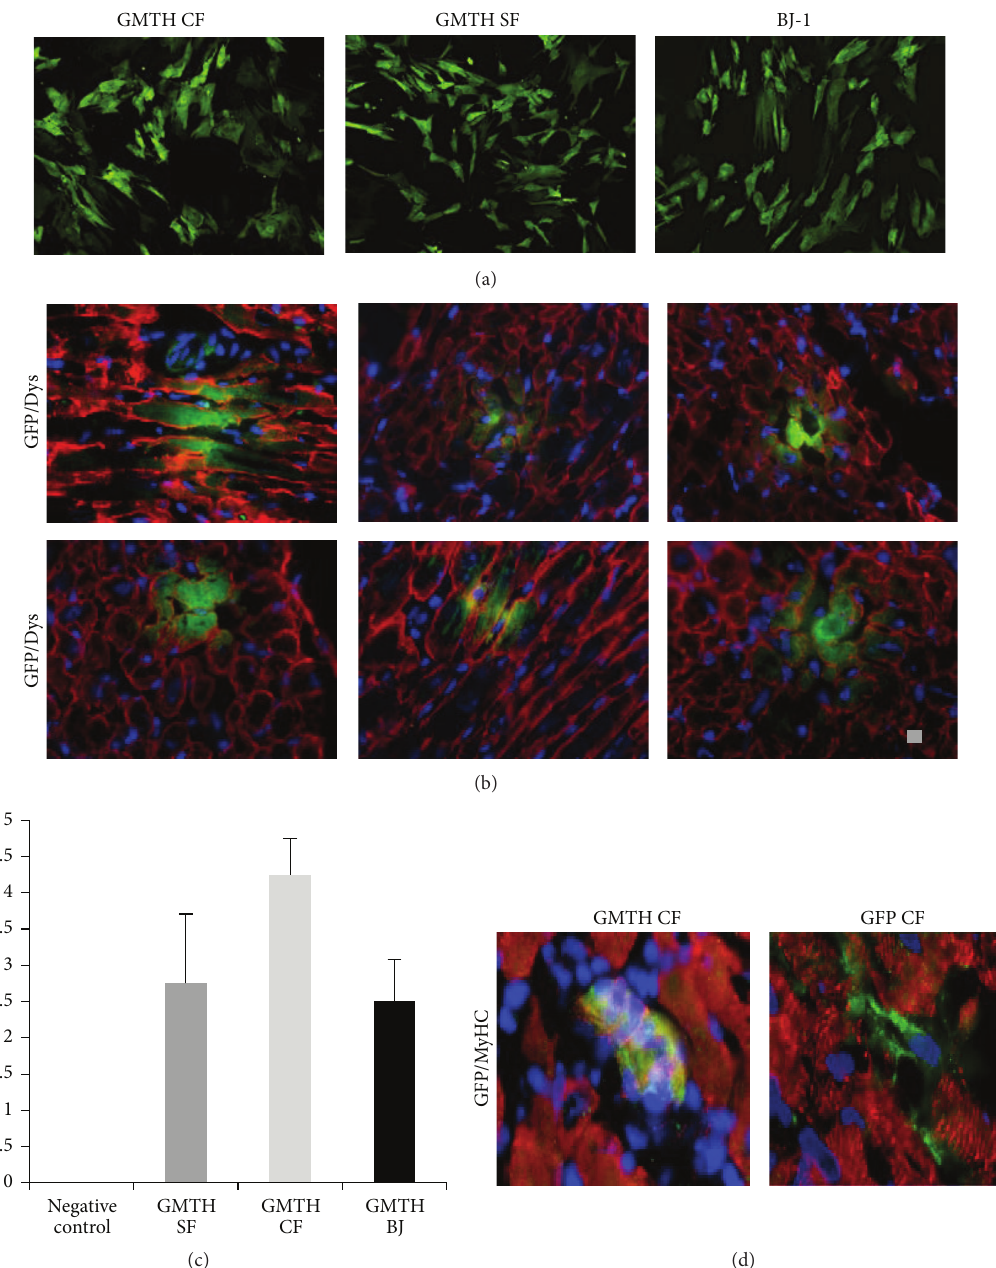
Figure 6: ciCLMs in vivo injection. (a) Immunofluorescence analysis for GFP expression ciCLMs after cell sorting for GFP and before injections. (b) 2 × 10 5 GFP positive cells were injected directly in the heart of 2-day-old pups. After 14 days pups were sacrificed and heart sections were prepared and double stained with antibodies against dystrophin (red) and GFP (green). (c) Average number of ciCLMs GFP positive cells per section; 𝑛 = 3 . (d) Double staining with antibodies against myosin heavy chain (red) and GFP